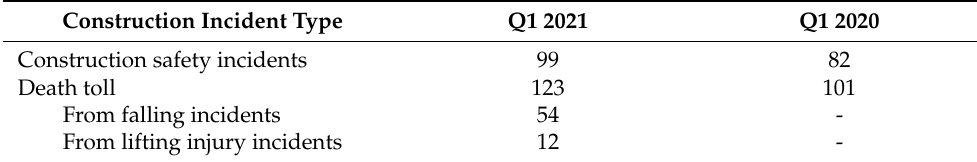
Table 1. Comparison of statistics on construction safety incidents in